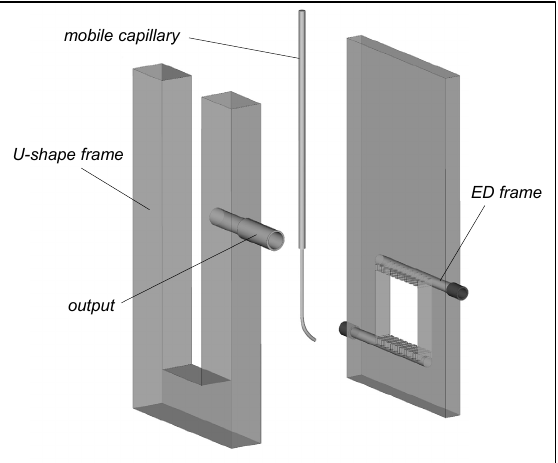
Figure 15. Scheme of the frame for the electrodialyzer. Adapted from [119].